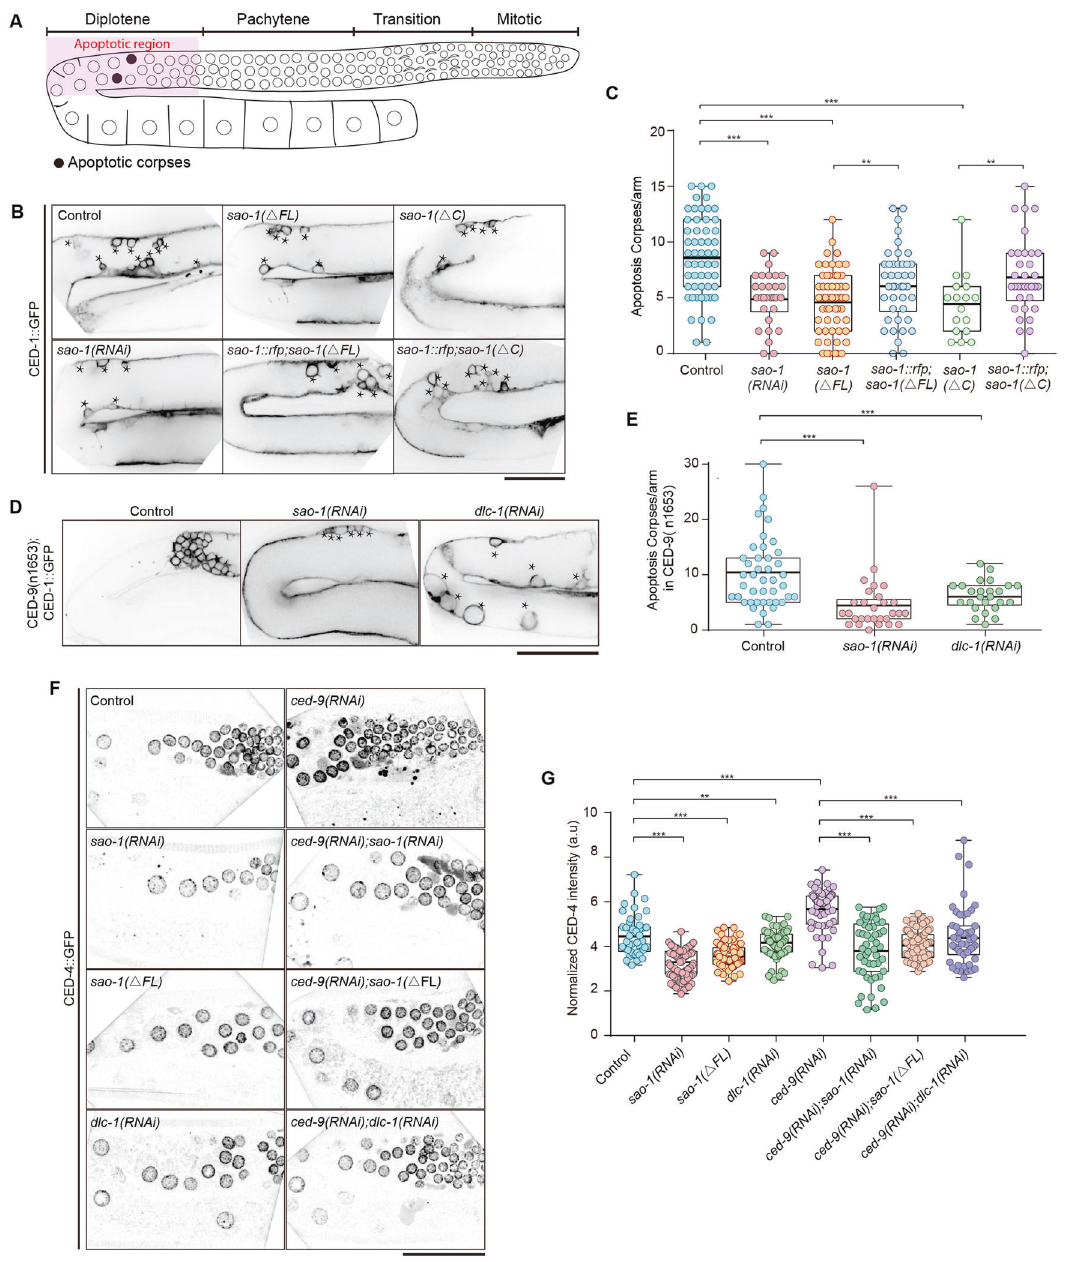
Fig. 2 SAO-1 and DLC-1 promote C. elegans germ cell apoptosis. A Schematic representation of the adult C. elegans hermaphrodite germline. B Representative confocal images of the apoptotic corpses labeled by CED-1::GFP (black asterisk) in control, sao-1 (RNAi) , sao-1( Δ FL) , sao-1( Δ C), Ex[sao-1::rfp] ; sao-1( Δ FL) and E x[sao-1::rfp] ; sao-1( Δ C) . Worms were imaged at 48 h after L4 molt. Asterisks: apoptotic corpses. The schematic representation of sao-1( Δ C) please refer to Fig. 4C. C Quanti fi cation of the number of apoptotic corpses in B , each dot in the chart represents a single worm. D Representative confocal images of the apoptotic corpses in ced-9(n1653) in control, sao-1(RNAi) , and dlc-1(RNAi) . E Quanti fi cation of the number of apoptotic corpses in D , each dot in the chart represents a single worm. F Representative confocal images of CED-4::GFP in control, sao-1(RNAi), sao-1( Δ FL), dlc-1(RNAi) , ced-9(RNAi) , sao-1(RNAi);ced-9(RNAi) , sao-1( Δ FL);ced-9 (RNAi) , and dlc-1(RNAi);ced-9(RNAi) . G Quanti fi cation of CED-4::GFP intensity in F , each dot in the chart represents a single nuclear. Data were analyzed by two-tailed Student ’ s t test; Error bars, ±SEM; **p < 0.01, ***p < 0.001. a.u., arbitrary unit. Scale bar, 50 μ